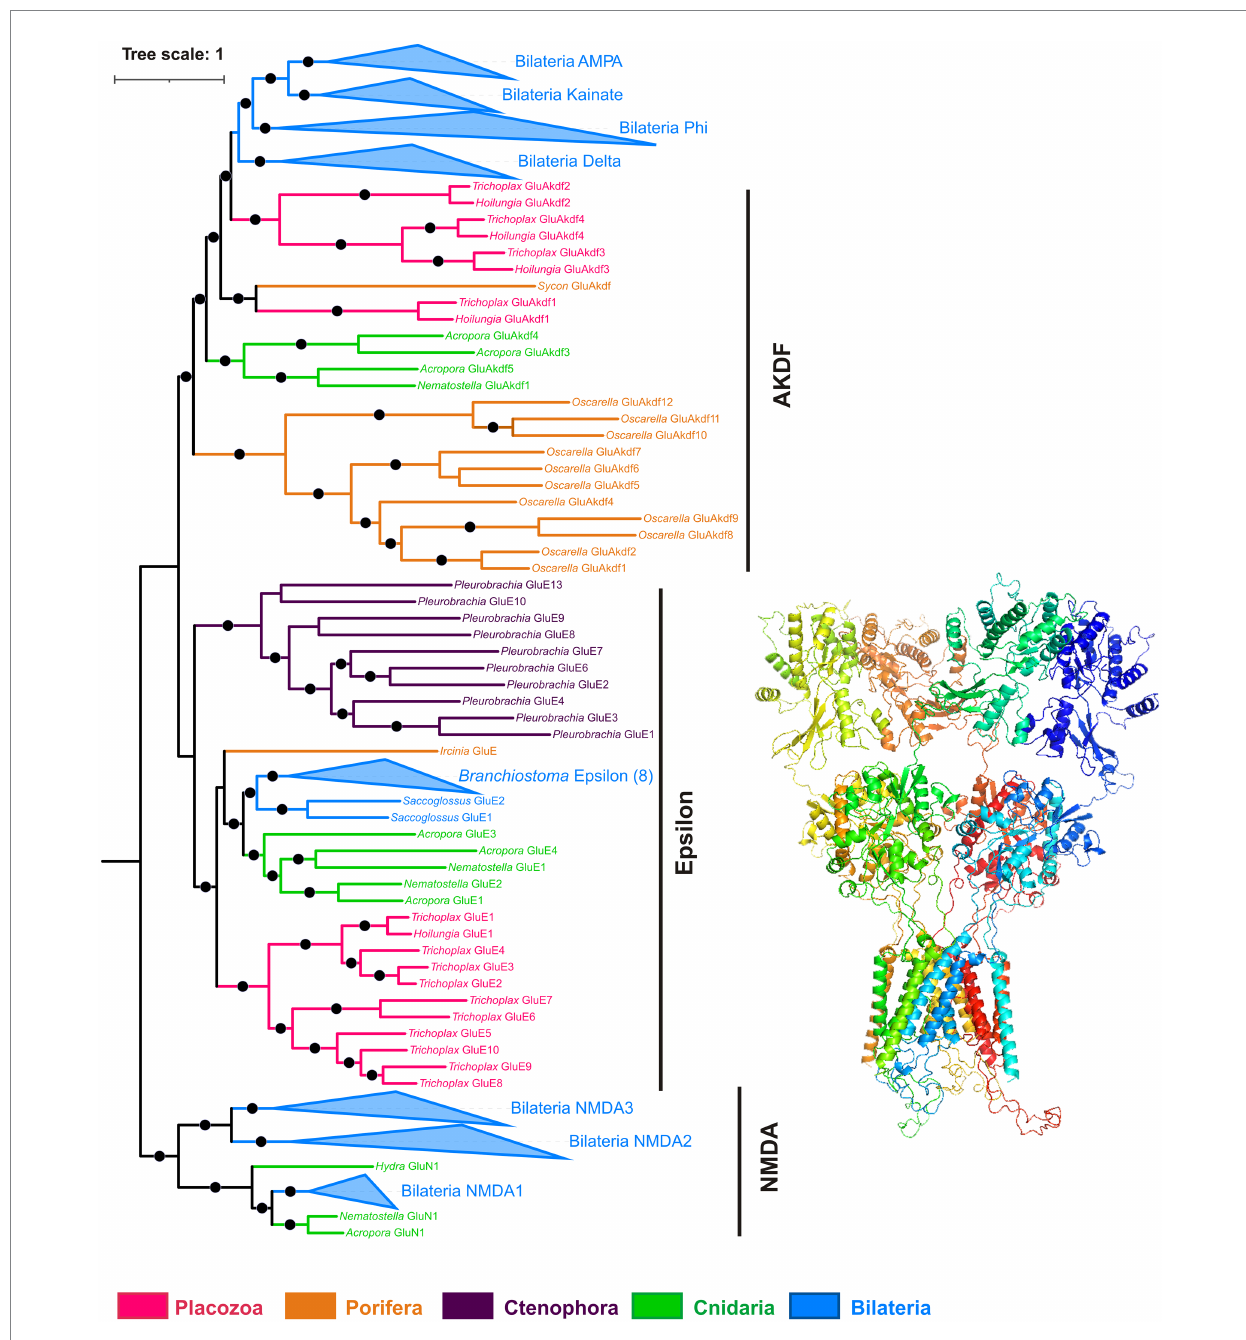
FIGURE 9 Phylogeny of ionotropic glutamate receptors (iGluRs). Bayesian phylogenetic tree of iGluRs has well-supported clades corresponding to most metazoan iGluR families (NMDA, AMPA, kainate, Delta, Phi, Epsilon), plus a paraphyletic group of AKDF-type receptors. Trichoplax has 14 iGluRs (4 AKDF and 10 Epsilon), and Hoilungia – has 5 iGluRs (4 AKDF and 1 Epsilon). Placozoan AKDF receptors split into two independent clades. Black dots mark highly supported nodes (Bayesian posterior probability > 0.75). Full uncollapsed trees with numeric support values can be found in Supplementary Figure